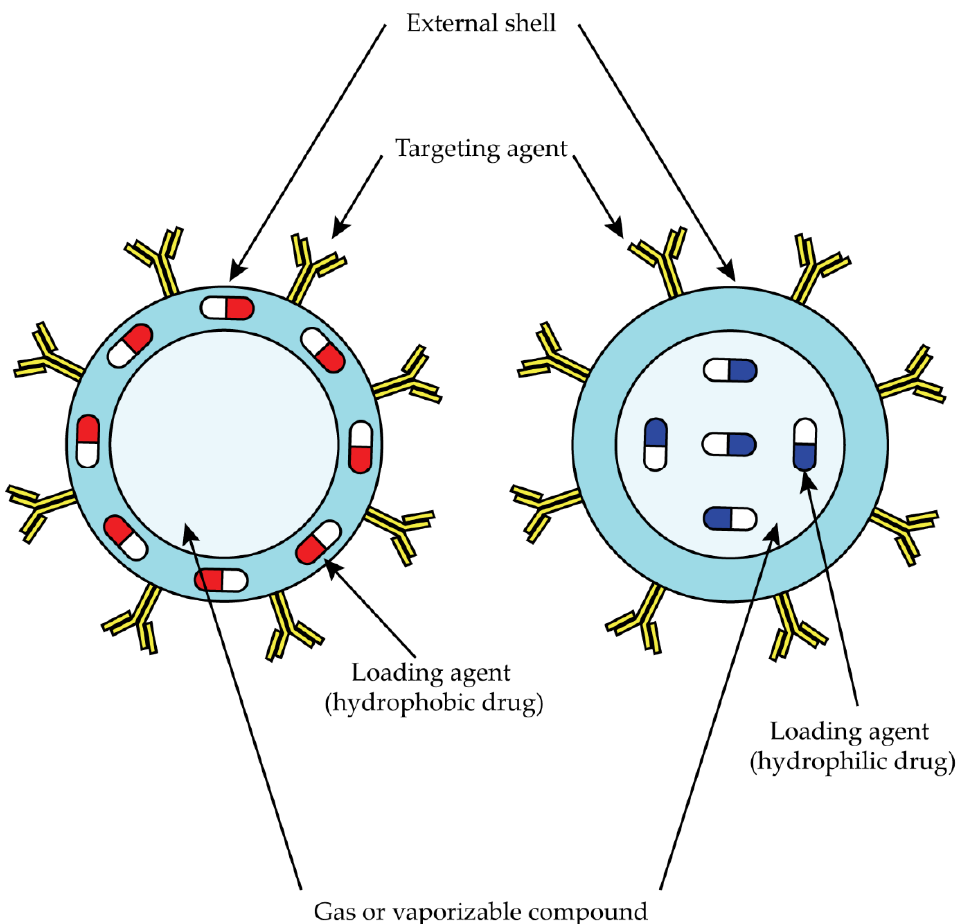
Figure 6. Schematic representation of NBs for drug delivery. Hydrophilic drugs are incapsulated in the external shell, and hydrophobic drugs are incapsulated in the gas core.